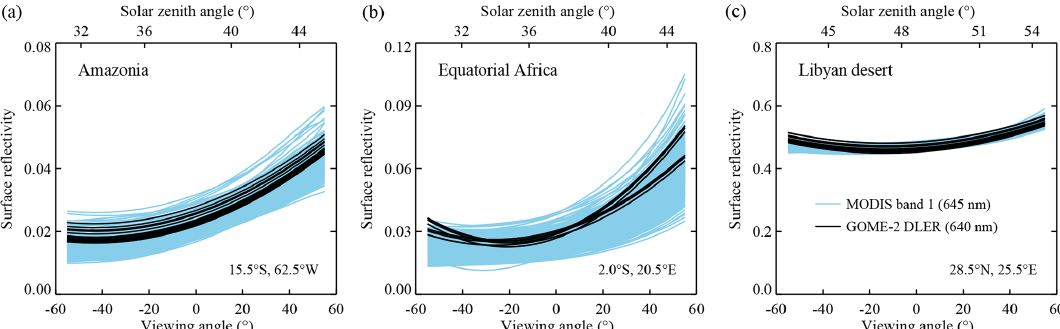
Figure 8. Surface reflectivity around 640nm according to the GOME-2 surface DLER database (black curves) and the MODIS surface BRDF product (blue curves), as a function of the viewing angle, for the Amazonian rainforest (a) , equatorial Africa (b) , and the Libyan desert (c) . Results are representative of 15 March 2008 and correspond to a one-by-one degree latitude and longitude box with the indicated central coordinates.